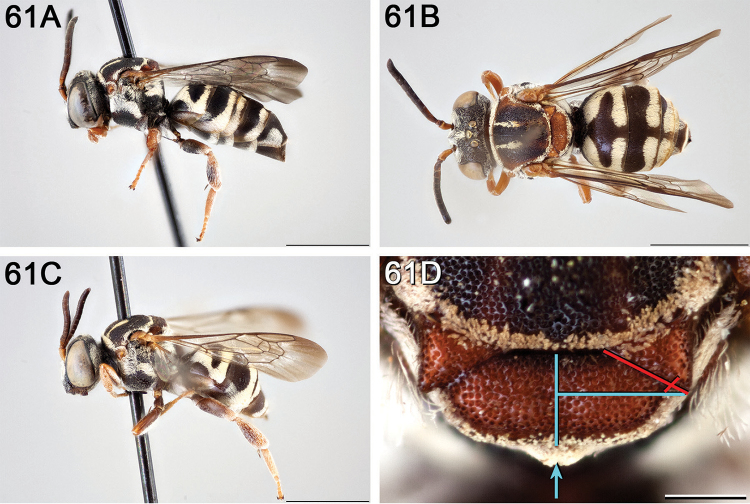

Epeolus
interruptus
A female, lateral habitus (scale bar 3 mm) B female, dorsal habitus (scale bar 3 mm) C male, lateral habitus (scale bar 3 mm), and D female axillae and mesoscutellum, dorsal view (scale bar 0.5 mm; blue arrow indicates blunt median process of metanotum; blue lines indicate the posterior extent of the axilla relative to the length of the mesoscutellum; red lines indicate the extent of the free portion of the axilla relative to its entire medial length).